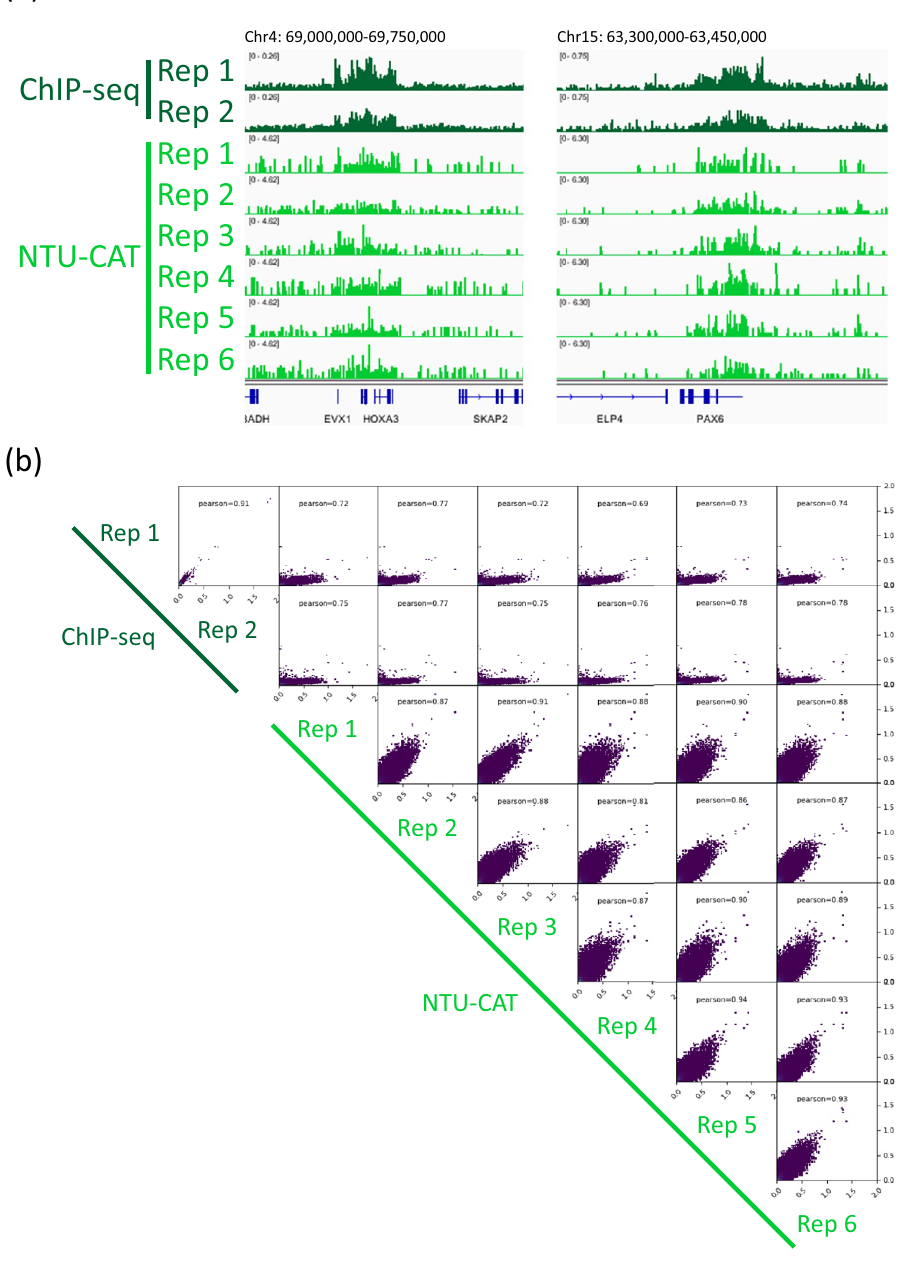
Figure 6. Comparison of the NTU-CAT and ChIP-seq results for H3K27me3 in bovine blastocysts. ( a ) Snapshot of the H3K27me3 landscape in representative positive regions, HOXA and PAX6 genes, respectively. The NTU-CAT-derived peaks in six replicates were visualized using Integrative Genomics Viewer 29 alongside the peaks from our previous ChIP-seq analysis of a cohort of blastocysts 17 . ( b ) Correlation analysis of duplicates of ChIP-seq and six replicates of NTU-CAT for H3K27me3 in bovine blastocysts. Scatterplots were generated using the same method as in Fig.